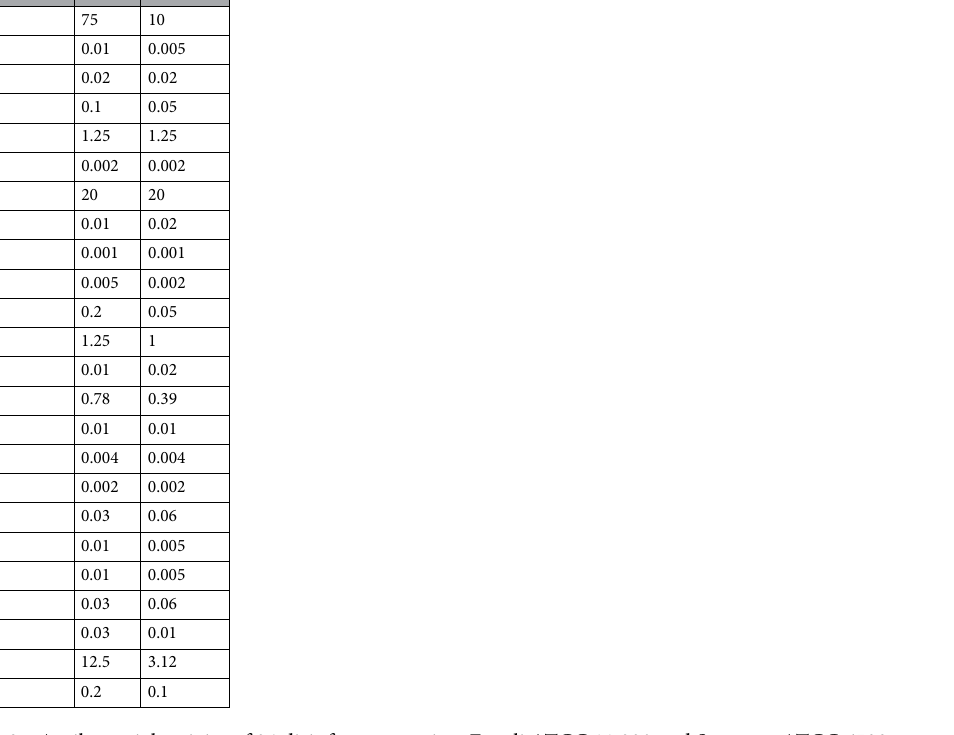
Table 2. Antibacterial activity of 24 disinfectants against E. coli ATCC 11,229 and S. aureus ATCC